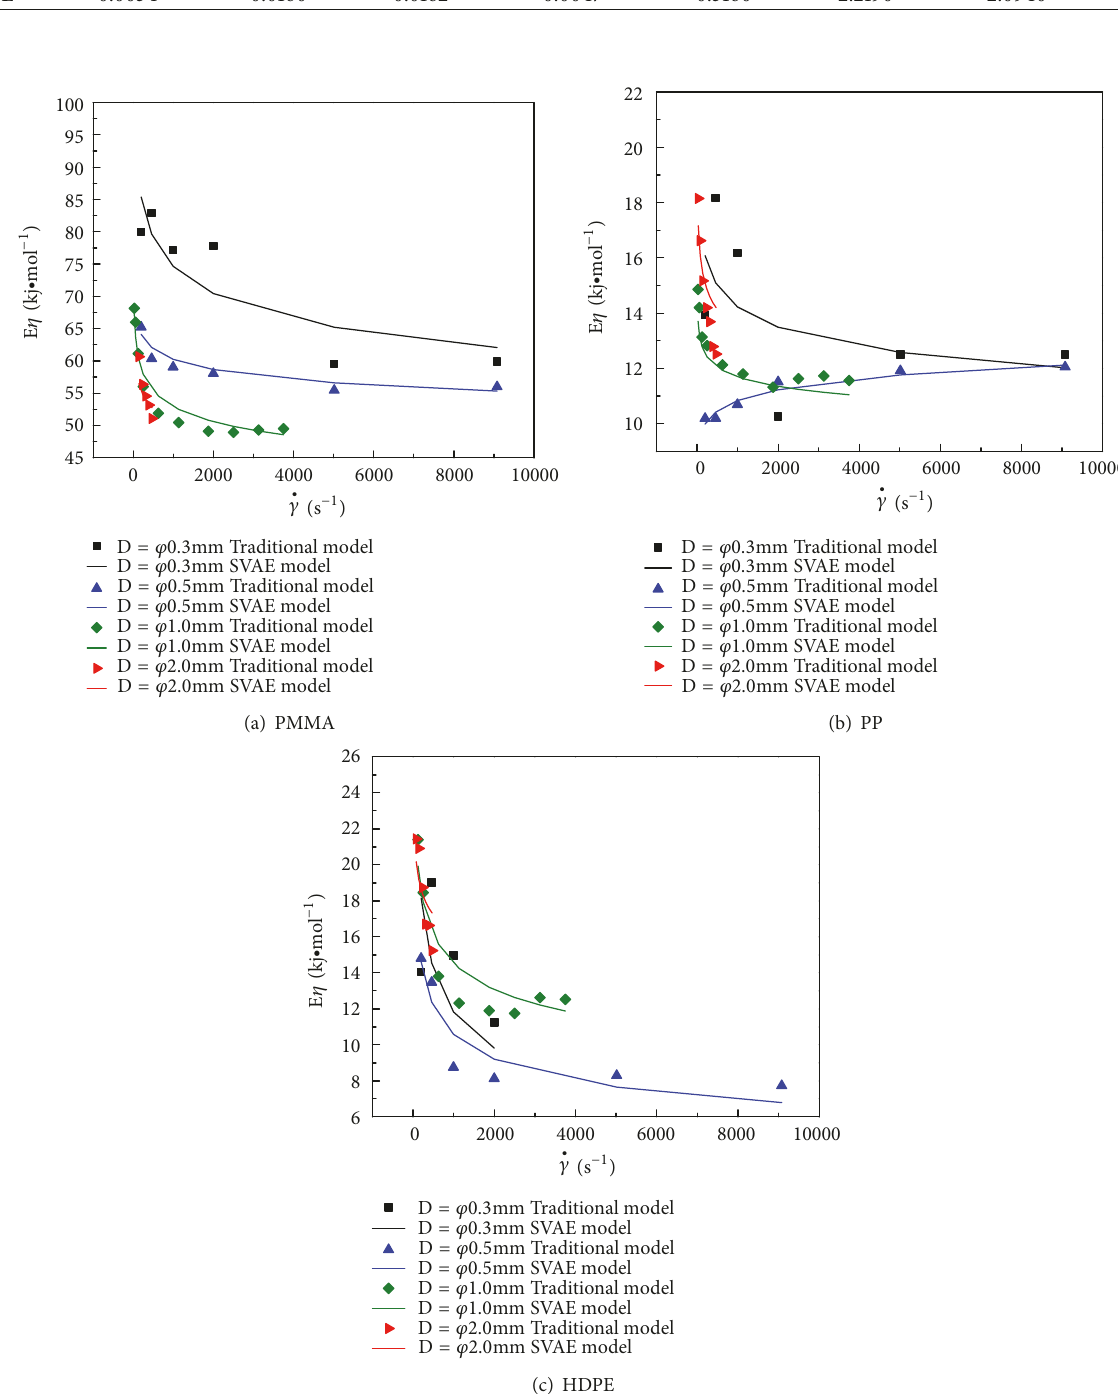
Figure 4: Comparison of viscous flow activation energy between conventional equation and SVAE model. (a) PMMA; (b) PP; (c)